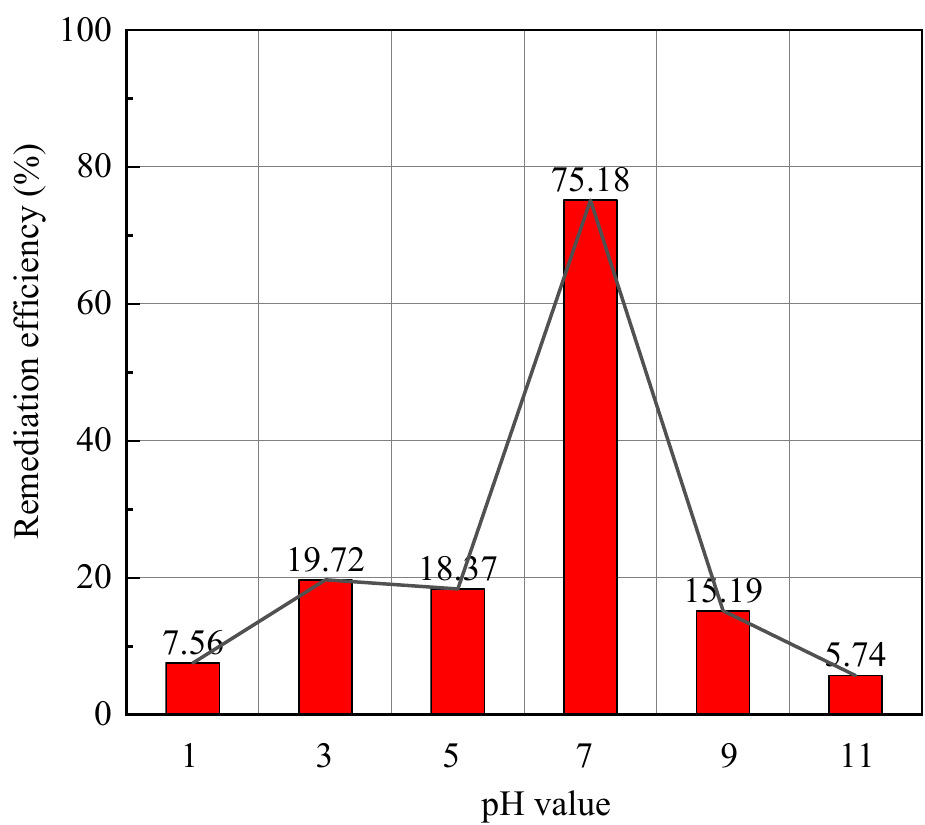
Figure 14. Frequency spectrum of microcapsules in various water environments: ( a ) pH = 1; ( b ) pH